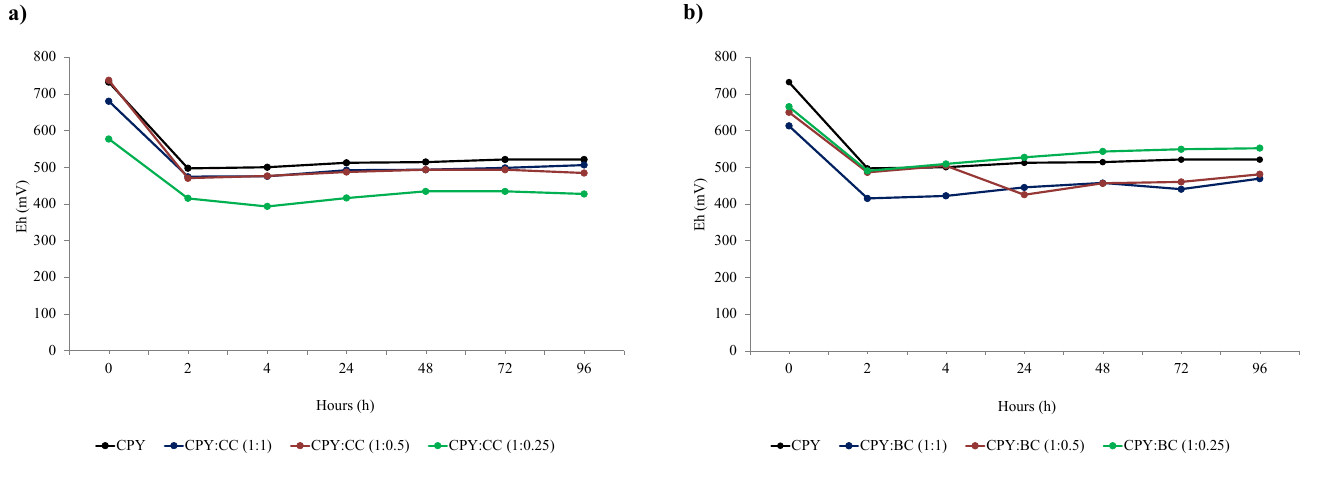
Figure 6. Eh (mV) evolution during leaching experiments with the addition of carbon materials: ( a ) CC and ( b ) BC .